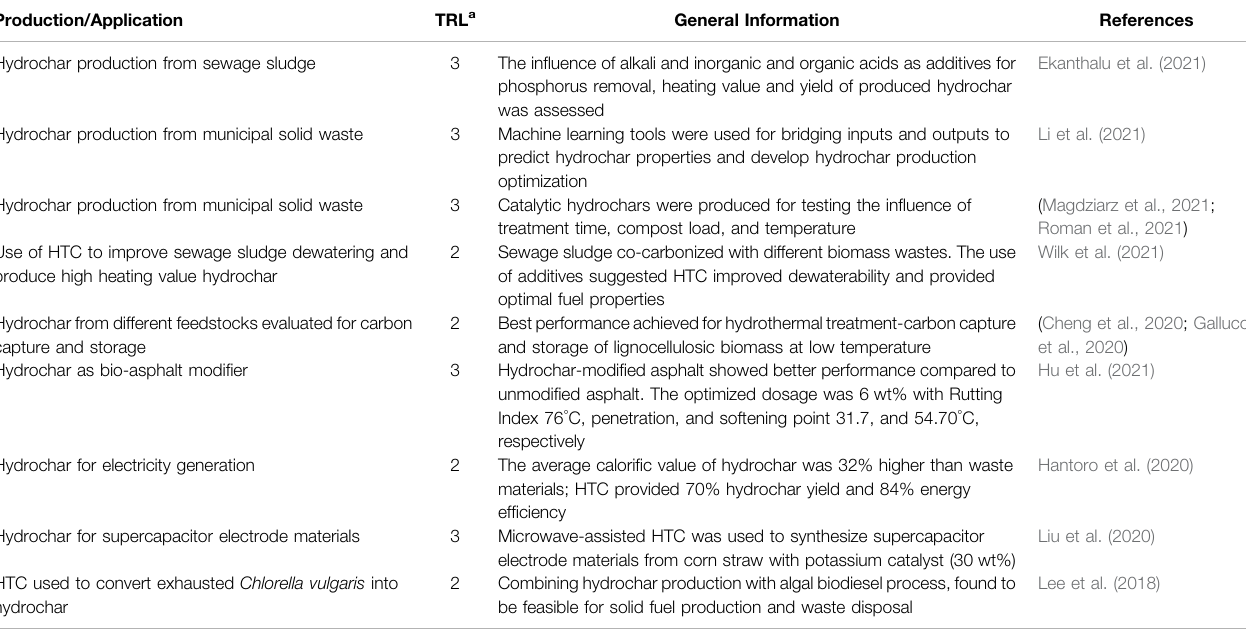
TABLE 2 | Hydrochar production and its applications in line with principles of circular